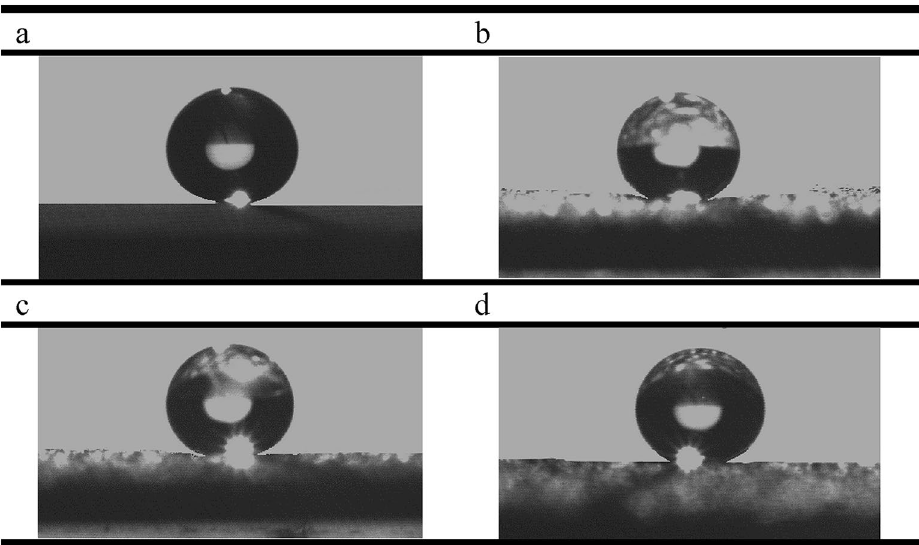
Figure 1. A water droplet on sample with PTFE and nanosilica superhydrophobic coatings: ( a ) nano silica 46 , ( b ) micro Al 2 O 3 —with nano SiO 2 , ( c ) micro glass beads—without nano SiO 2 , ( d ) micro glass beads—with nano SiO